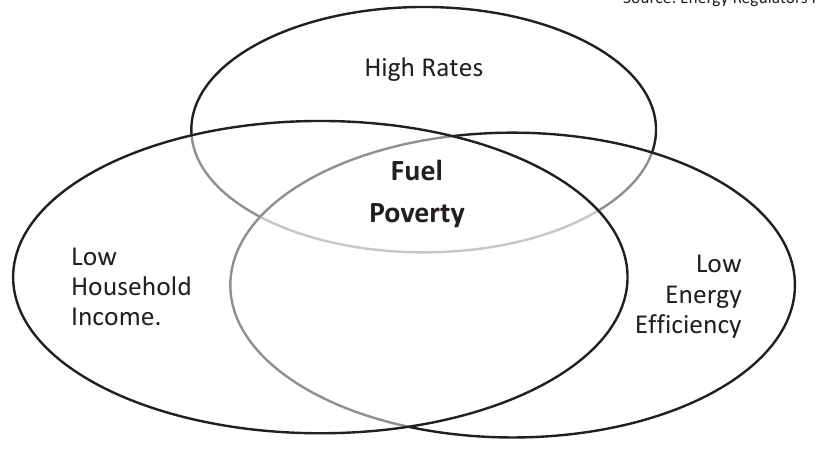
Figure 1. “Fuel poverty”